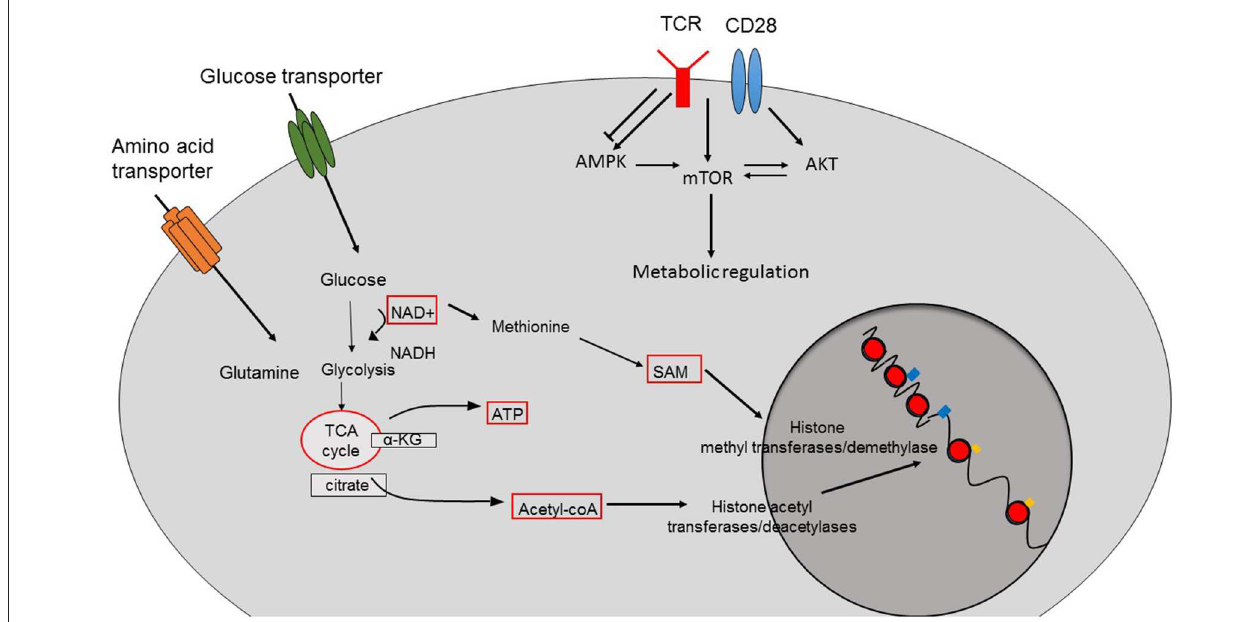
FIGURE 1 | Crosstalk between cellular metabolism and epigenetic changes. The function of epigenetic modifier enzymes depends on the intermediates or the products of cellular metabolism pathways resulting in epigenetic changes and therefore the transcriptional programs of the cells. Acetyl-CoA is the main source for histone acetylation leading to open and permissive chromatin structure. SAM is used by histone methyltransferases and demethylases. The function of sirtuin deacetylases depend on the availability of NAD. TCR-induced activation of pathways such as AMPK, mTOR, and AKT also contributes to the metabolic reprogramming of CD8 + T